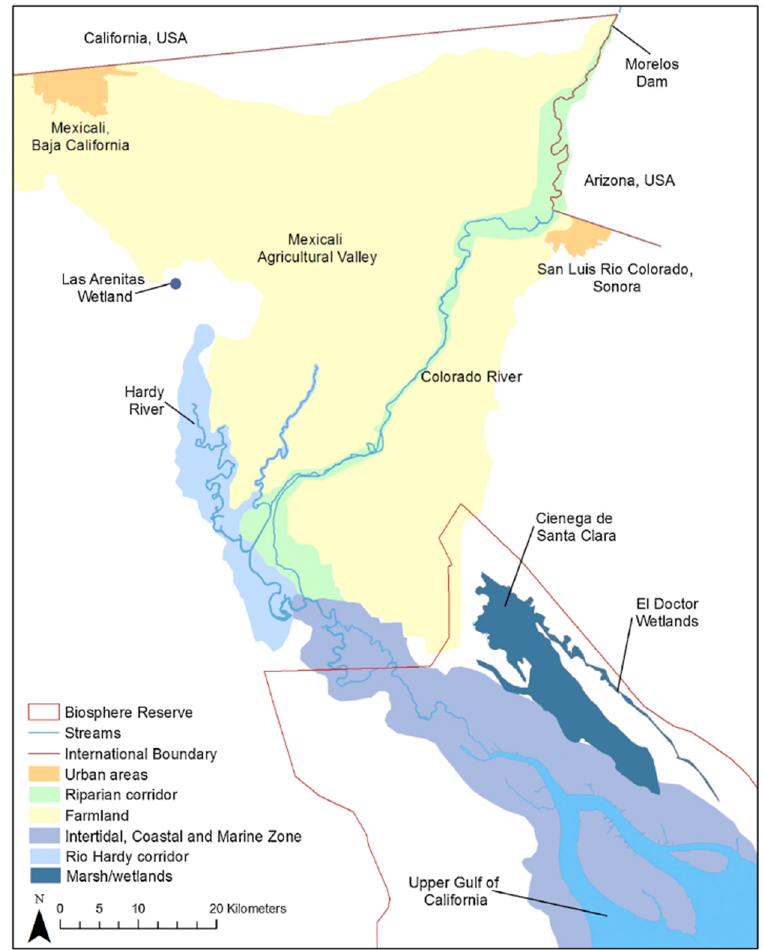
Figure 2. Wetland restoration areas of the Colorado River Delta (adapted from Ref. [22]).